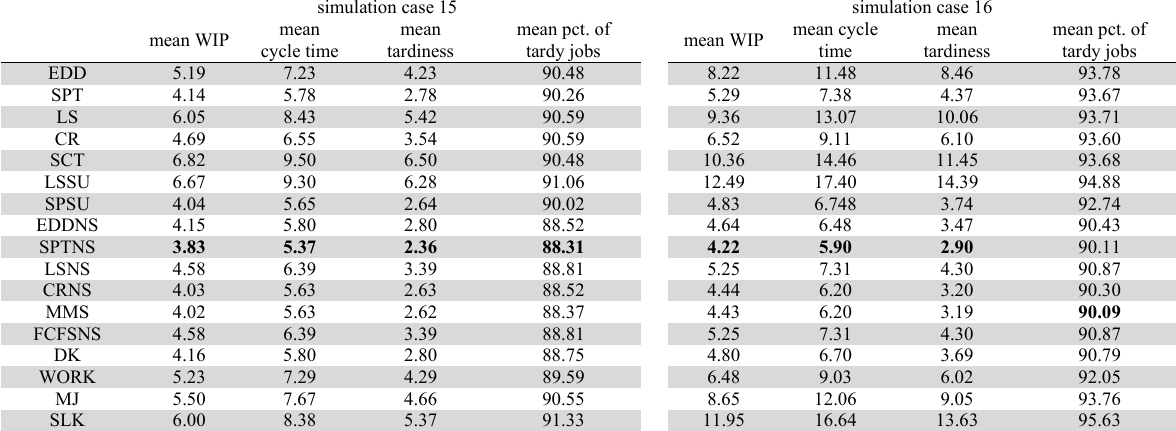
Results for simulation cases 15 and 16. The minimum values for each performance metric and simulation case are denoted in bold